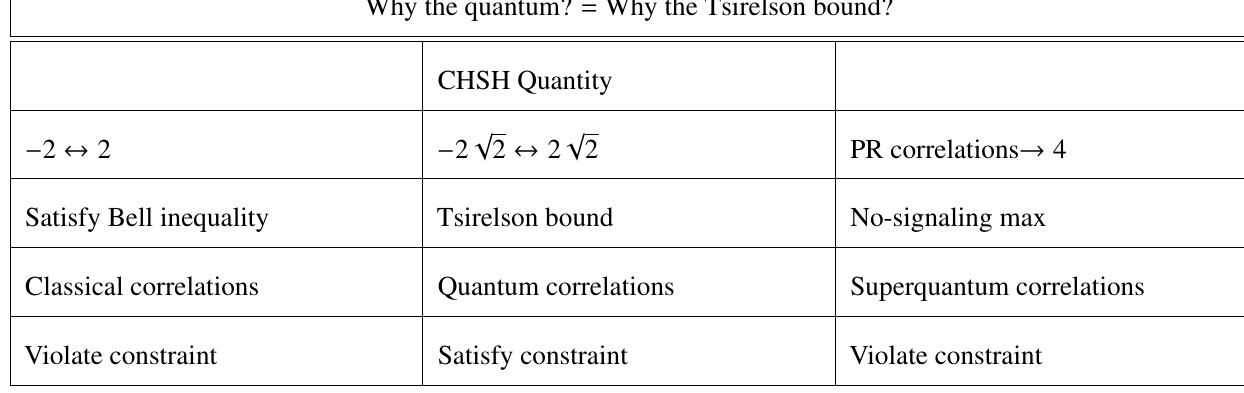
Figure 9: Bub’s version of Wheeler’s question “Why the quantum?” is “Why the Tsirelson bound?” [29,30]. The “constraint” is conservation per no preferred reference frame (NPRF). Reproduced from Stuckey et al. [11].